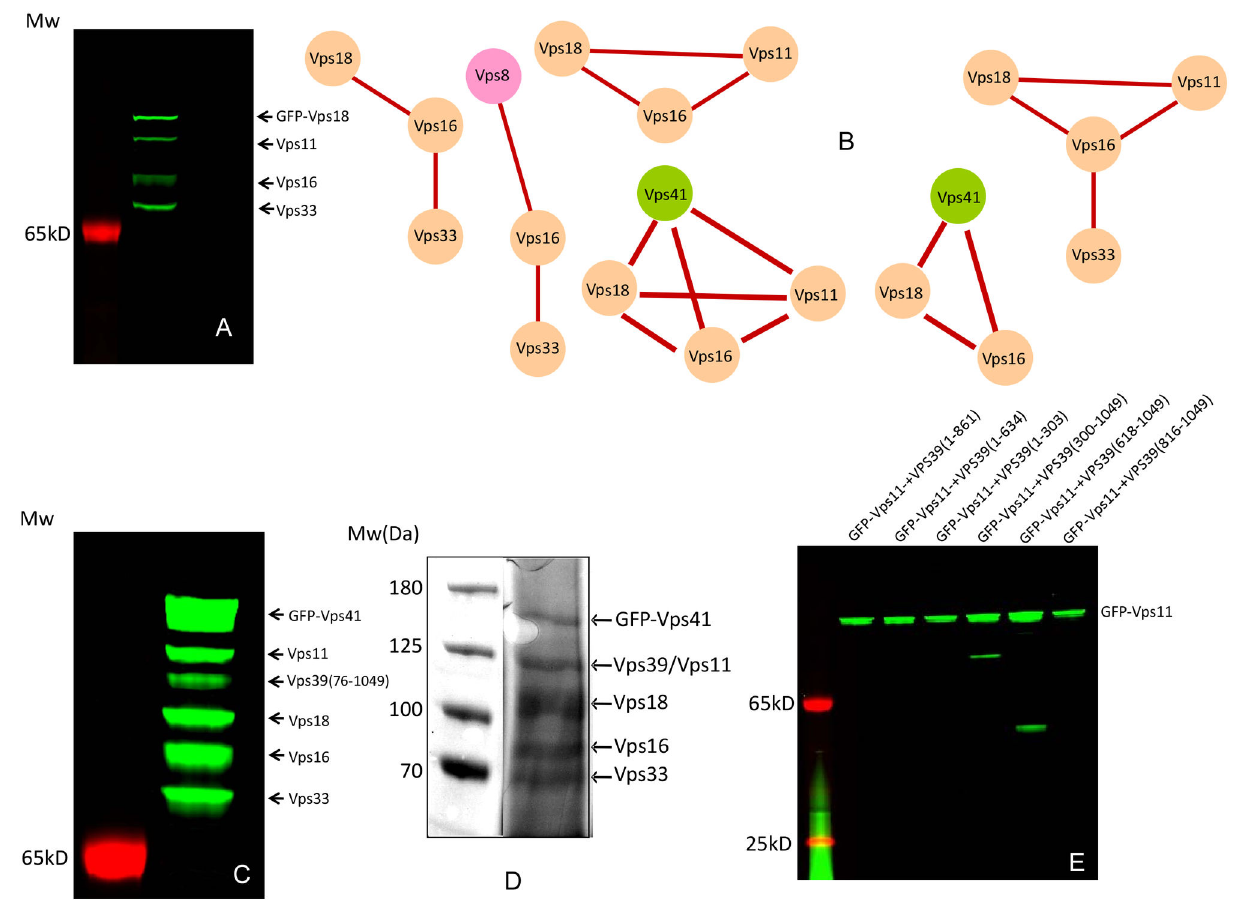
Figure 2. In vitro assembly of subcomplexes of HOPS and CORVET complexes. (A) An example of subcomplex containing Vps11, Vps16, GFP-Vps18 and Vps33 co-expressed in LTE extract and isolated on the anti-GFP matrix. (B) Graphic summary of subcomplexes isolated in this study. (C) Fluorescence scan of the SDS-PAGE gel loaded with in vitro reconstituted and affinity purified HOPS complex. The positions of the individual subunits are indicated on the right hand side. (D) Coomassie stained SDS- PAGE loaded with the HOPS containing fraction eluted from the gel filtration column. (E) Identification of the complex forming domains in the Vps subunits of HOPS and CORVET complex. GFP-tagged Vps11 was co-expressed with the truncated variants of Vps39 subunit. The samples were processed as in